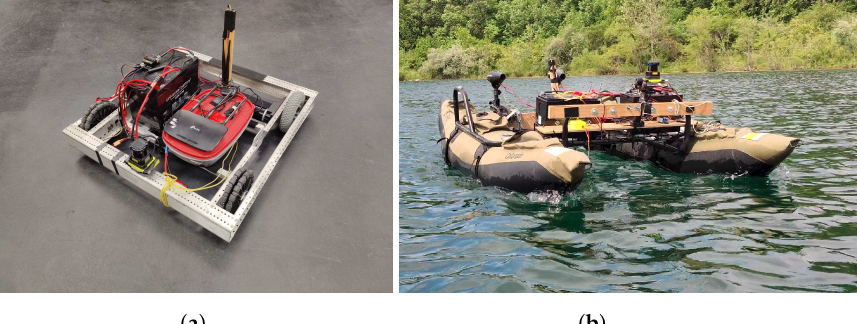
Figure 7. USV and UGV vehicles built for use in cross-domain DRL development. ( a ) UGV. ( b ) BREAM.